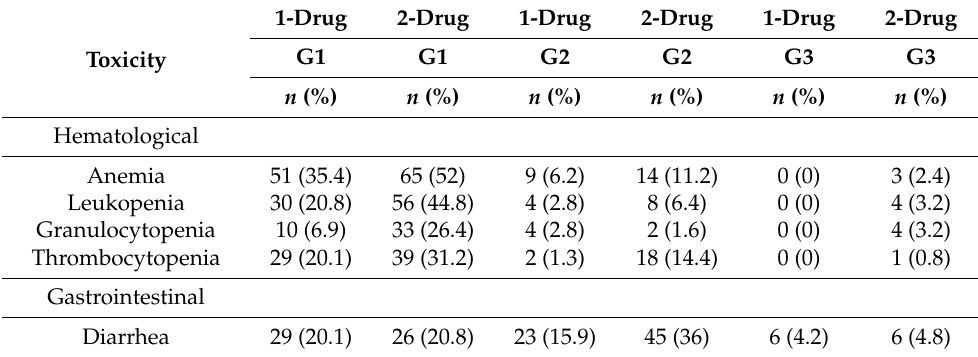
Table 3. All grade (G) toxicity in the two groups (1-drug vs. 2-drug chemotherapy).